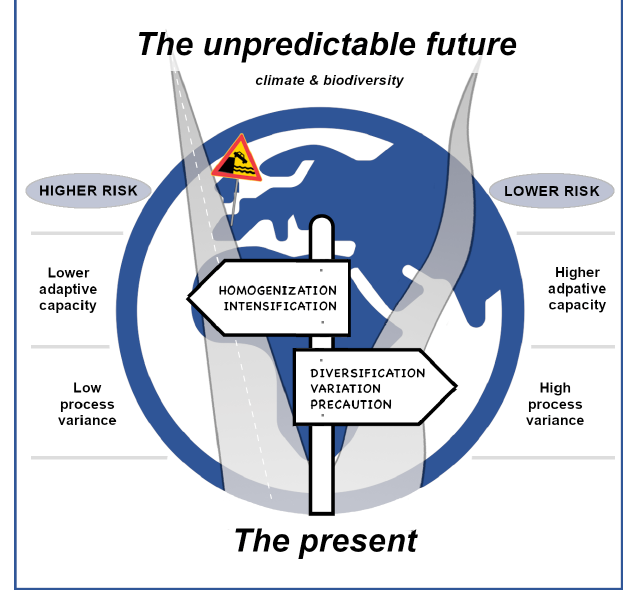
Fig. 2 . Today’s predicament: the choice between a high risk (homogenous, intensified, and centralized) and a low risk (diverse, variable, precautionary)